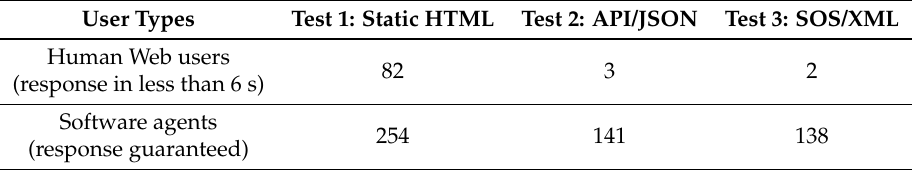
Table 4. Estimates on the number of clients that Airchive can serve